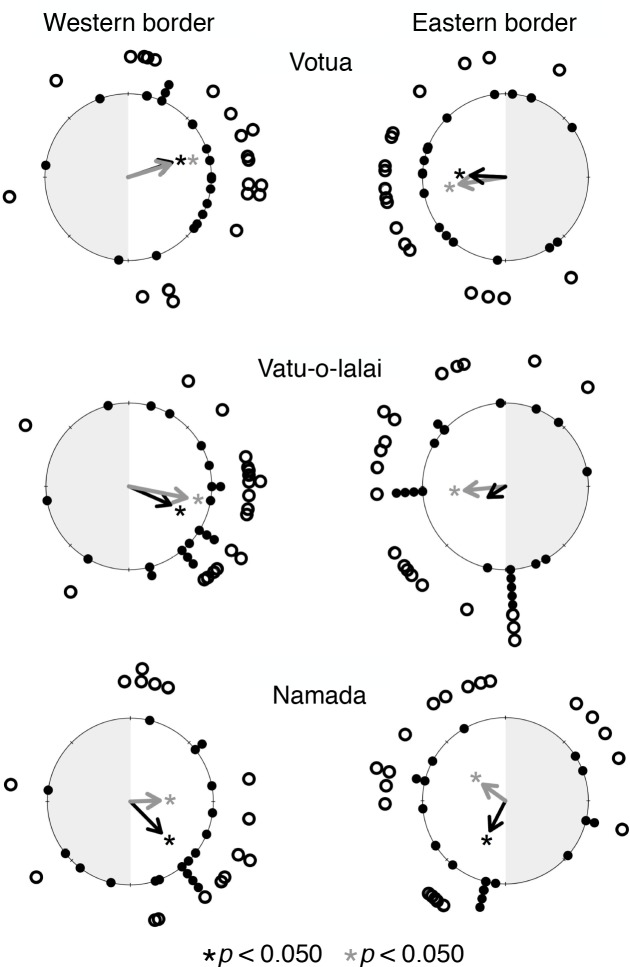
Acanthaster move selectively to Marine Protected Areas (MPAs).Movement directions of initial (solid dots) and final (open dots) Acanthaster relocations from release points at MPA/non-MPA borders on each side of the MPA at each of the three villages. Arrows represent the resultant vector (R) for initial (black) and final (gray) relocations. * and * indicate a significant difference between Acanthaster movement towards MPAs (white region) rather than fished areas (shaded region) (Modified Hodges-Ajne test, p < 0.050).